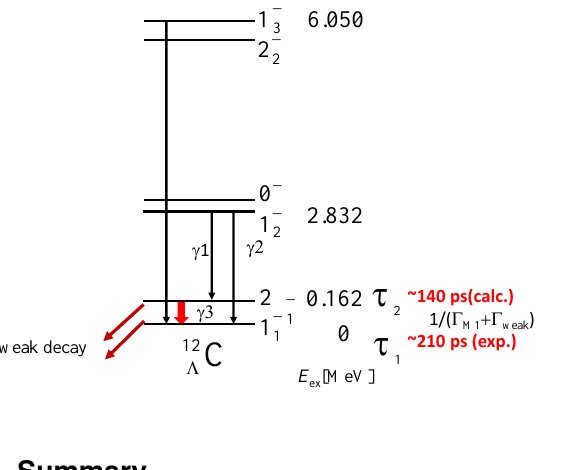
Figure 6. Level scheme of 12 (cid:3) C bound states. The excitation energies are measured in the Hyperball project